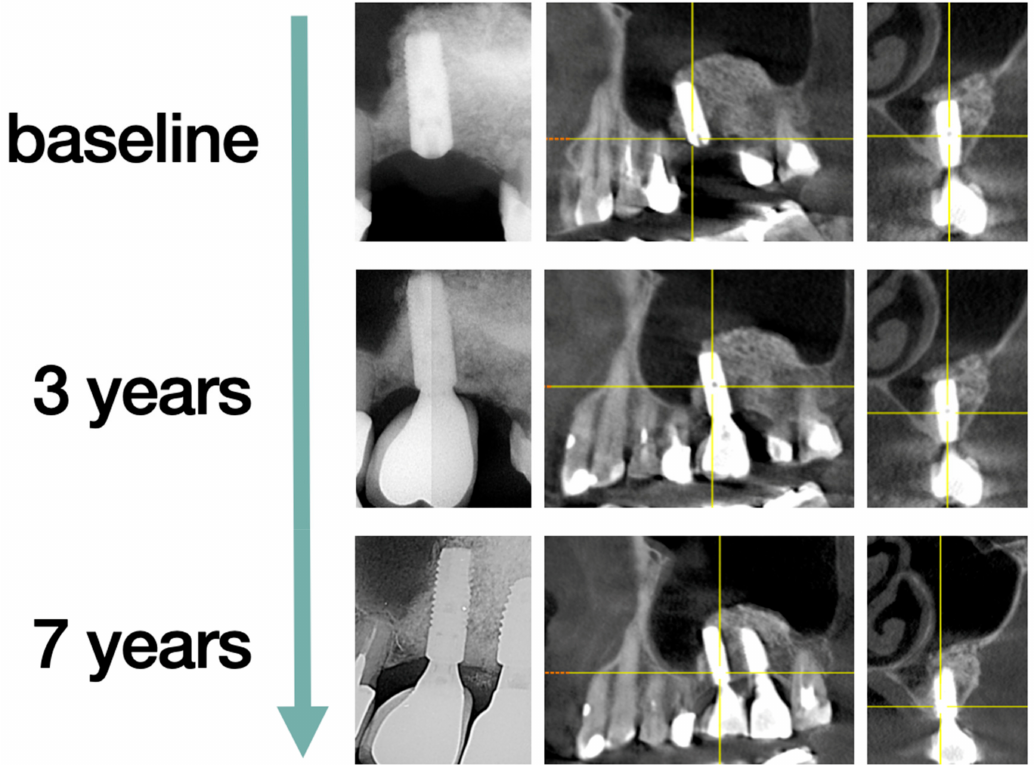
Figure 3. Regular implants. The same patient from baseline to seven years, implant tooth 26, follow-up. The second implant was placed after tooth 27 was lost and restored with a second single implant crown and is not included in the measurements. Periapical X-ray and CBCT are